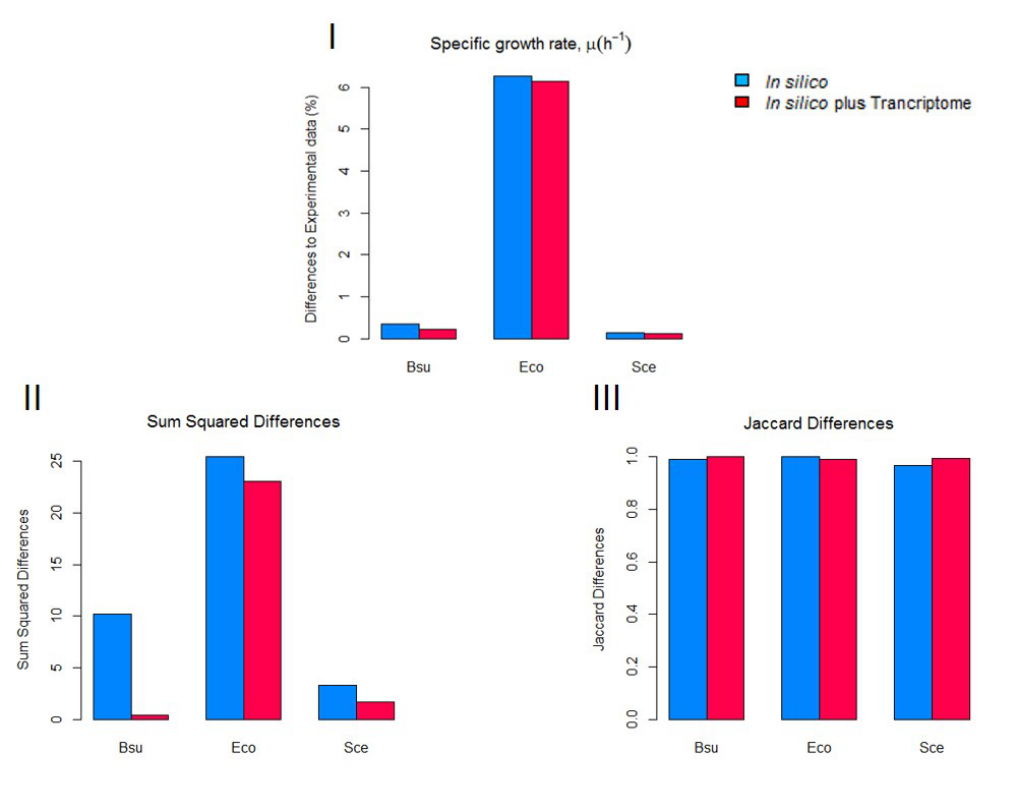
Figure 5: Differences in specific growth rate and flux distribution predictions when changing the biomass coefficients for amino acids in genome-scale metabolic models from the ones experimen- tally determined to the ones determined in silico from genomic and genomic + transcriptomic information. (I) Differences in the specific growth rate, ( h − 1 ) obtained, (II) Sum of squared dif- ferences of flux distribution and (III) Jaccard coefficient for flux distributions. Abbreviations: